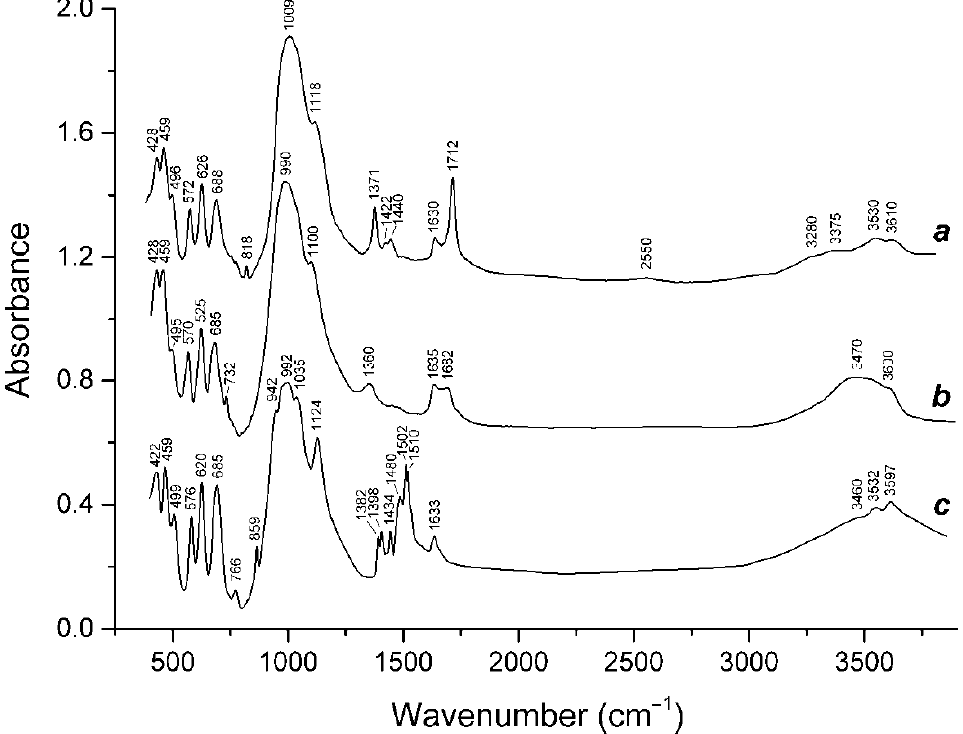
Figure 1. Infrared spectra of ( a ) kyanoxalite from Alluaiv Mountain (Sample 5), ( b ) kyanoxalite from Flora Mountain (Sample 6), both Lovozero massif and ( c ) cancrinite from the Kovdor massif (Sample 1).